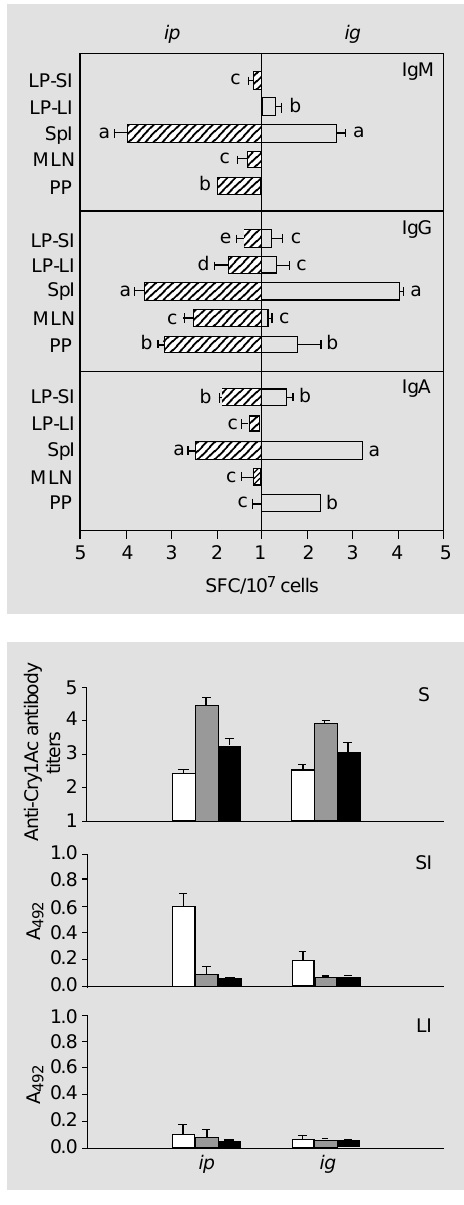
Figure 6 - Anti-tCry1Ac antibody production in mice immunized by the ip or ig route. The levels of IgM (open bars), IgG (gray bars) and IgA (black bars) anti- bodies were determined in se- rum (S) and in the fluid of the small (SI) and large intestine (LI) by ELISA. Nonimmunized mice showed serum antibody titers <1 and intestinal contents with A 492 <0.073 ± 0.031. Bars rep- resent the level of antibodies ± SD for each experimental group (N